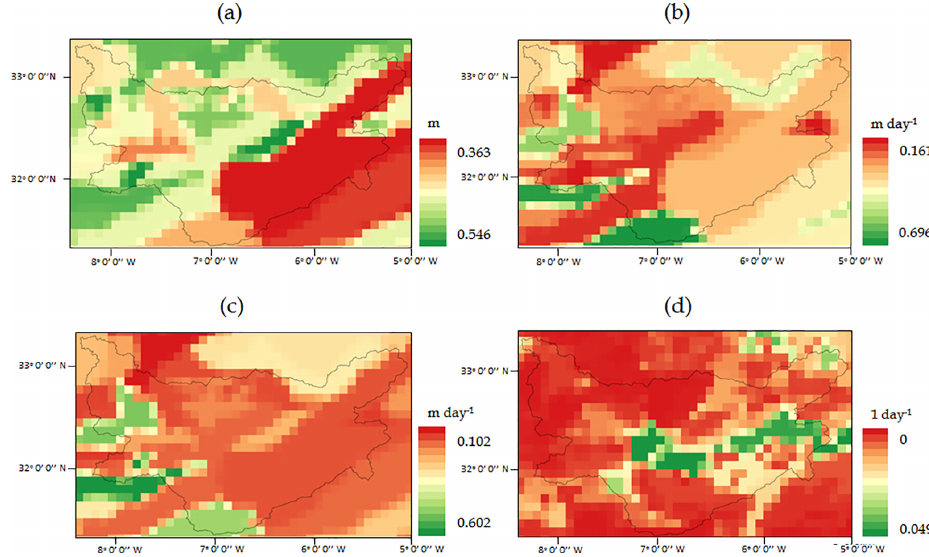
Figure A1. Initial model parameter values for the S0 calibration scenario (reference): (a) total soil water storage capacity ( W max = SC 1 + SC 2 + SC 3 ), (b) saturated hydraulic conductivity of the first and second soil layers ( K sat1 and K sat2 ), (c) saturated hydraulic conductivity of third soil layer ( K sat3 ) and (d) baseflow recession coefficient ( J